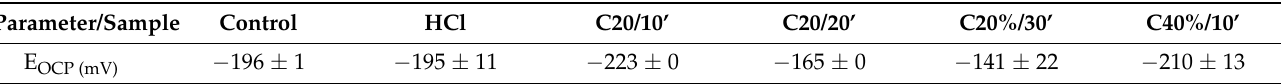
Table 4. Open circuit potential for the different passivation treatments.